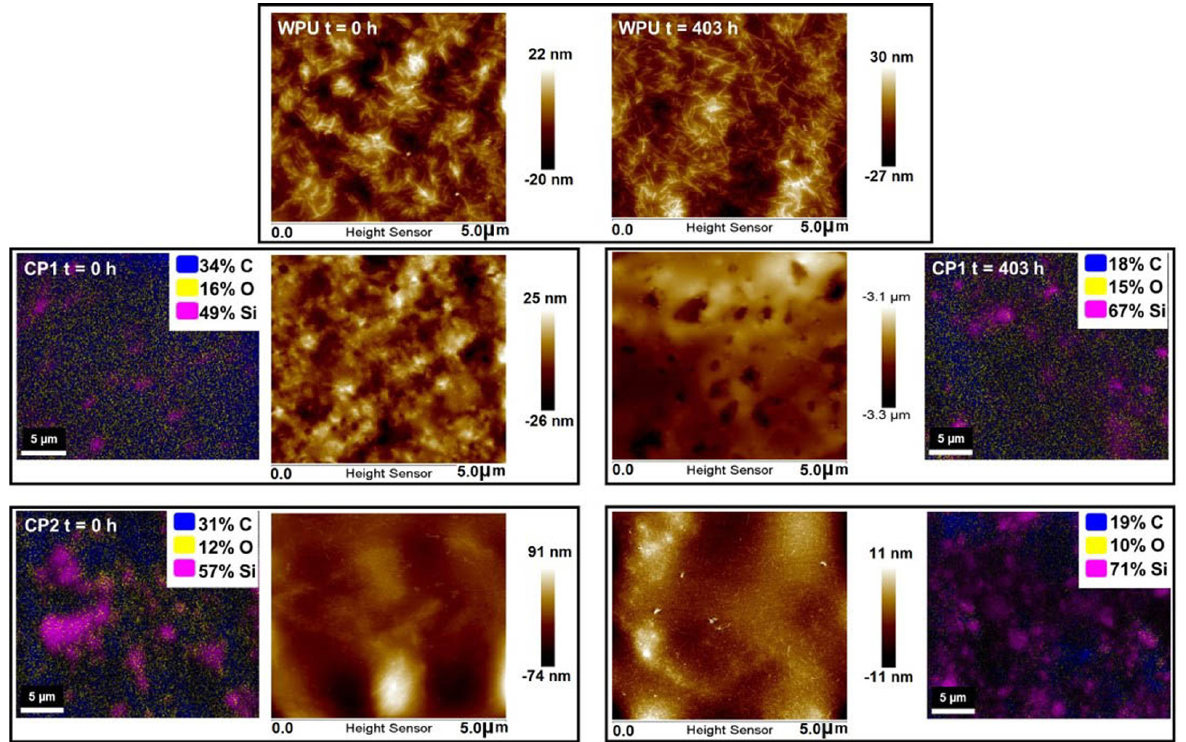
Figure 4 - EDS mapping and AFM of the samples exposed to the accelerated aging tests (Color figure can be viewed in the online